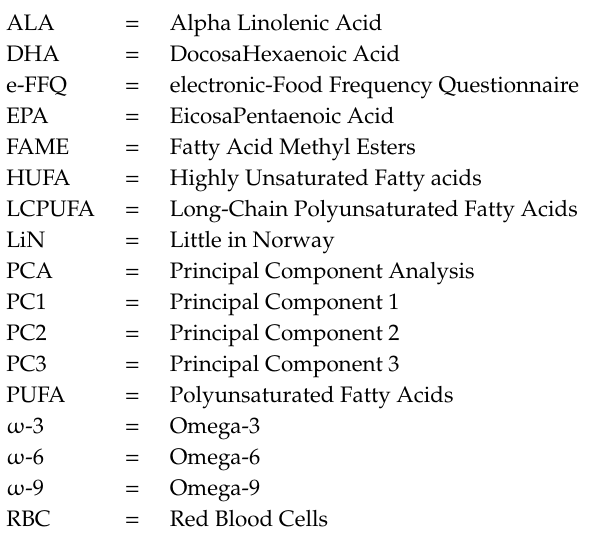
Table S1: Fatty acid composition of the di ff erent brands of ω -3 supplements that were consumed by the participants. Table S2: Excel-based platform for generating automatically the normal distributions for the di ff erent fatty acids at the di ff erent health stations and the total fatty acid distributions. Table S3: Experimental e-FFQ ( n = 203) and fatty acid ( n = 247) results. The fatty acid results are expressed as relative (%) and absolute (mg / g RBC wet